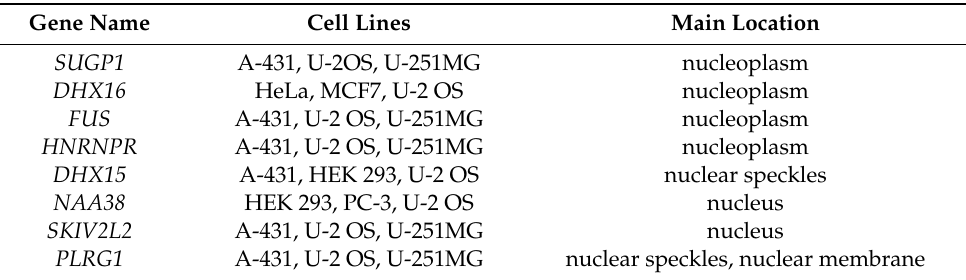
Table 3. The distribution of the hub genes in